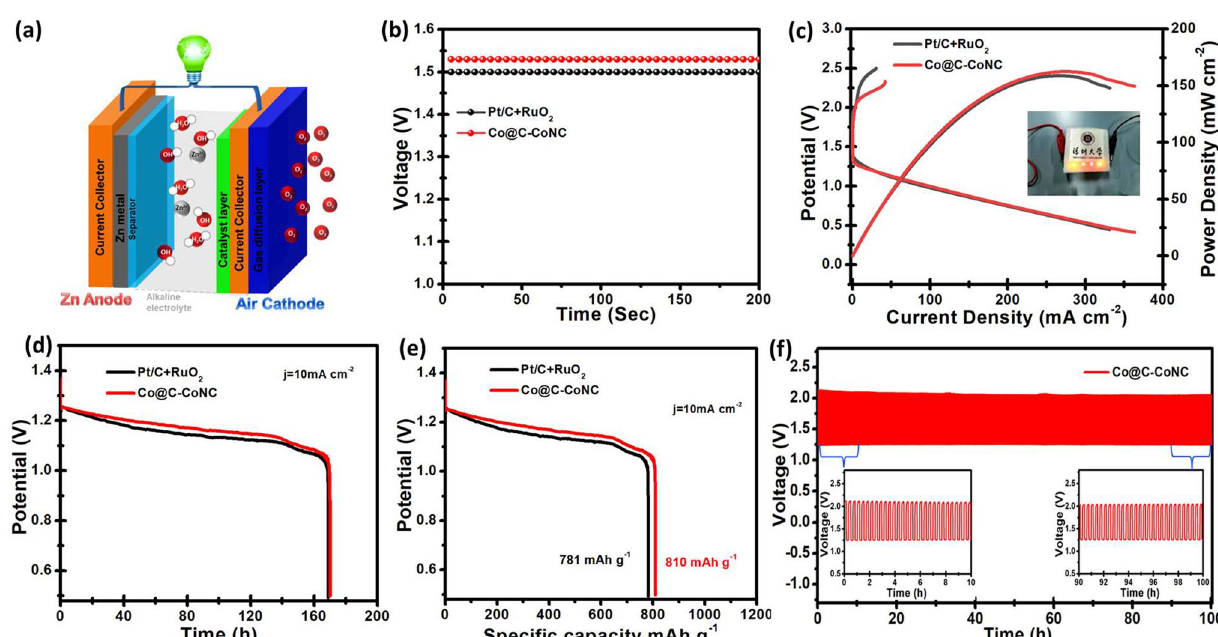
Fig. 6 a Schematic of the ZAB; b Open circuit plots; c Charging and discharging polarization curves and the corresponding power densities for ZABs based on Co@C-CoNC and Pt/C + RuO 2 , in which the inset shows LEDs powered by a Co@C-CoNC based ZAB; d The galvanostatic discharge curves and e specific capacities of ZABs made by Co@C-CoNC and benchmark Pt/C + RuO 2 catalysts at 10 mA cm −2 , respectively; f Long-term cycling test at a current density of 2 mA cm −2 for Co@C-CoNC based